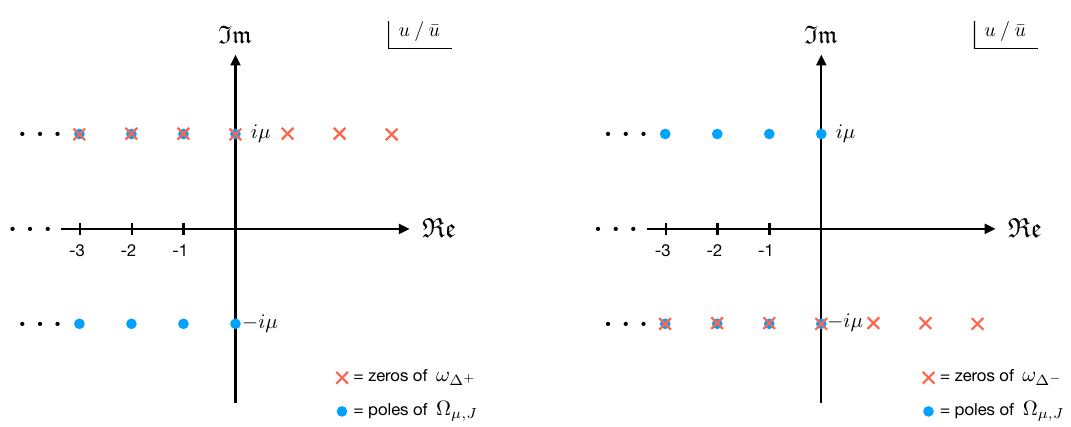
Figure 5. In both plots the blue dots represent the poles (2.28) in the internal Mellin variables u and ¯ u . Left : the crosses mark the zeros of the projector ω ( u, ¯ u ) which overlap with the poles of ∆ + Ω AdS in the upper-half plane that violate the ∆ + boundary condition. Right : the crosses mark the µ,J zeros of the projector ω ( u, ¯ u ) which overlap with the poles of Ω AdS in the lower-half plane that ∆ − µ,J violate the ∆ − boundary